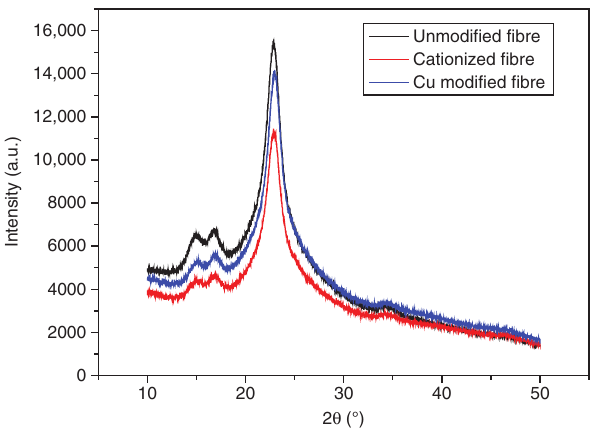
Figure 8: XRD patterns for different fibers unmodified, cationized, and Cu modified flax